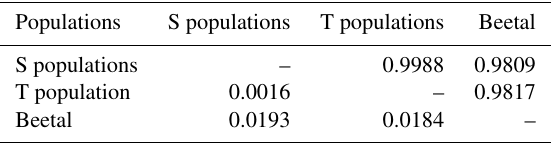
Table 6. Nei’s (1978) genetic identity (I, above diagonal) and ge- netic distance (D, below diagonal) between the Beetal breed and the single (S) and twin-birth (T) subpopulations of the other breeds